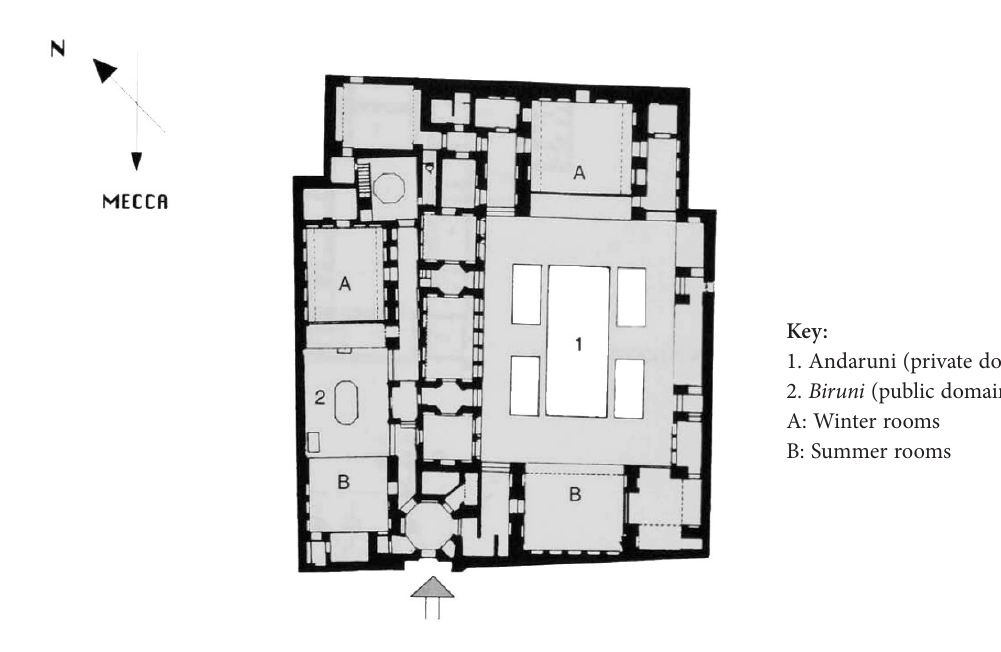
Figure 4. Ground floor plan of Rasoolian courtyard house, Yazd, Iran; Not to